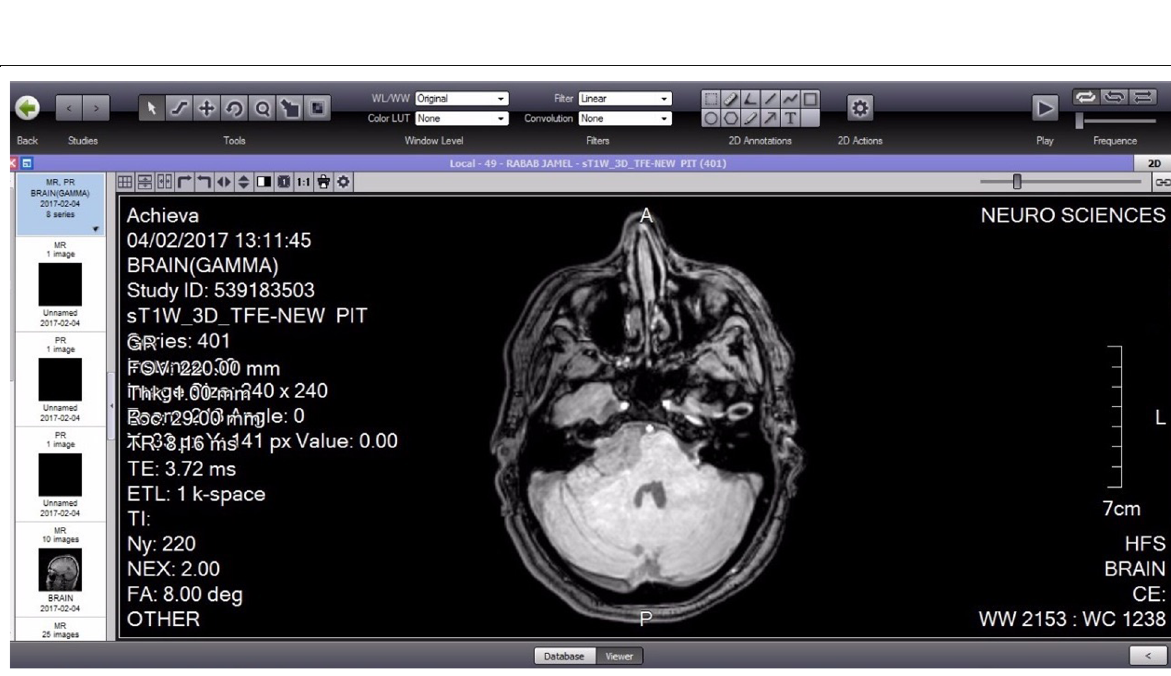
Fig. 2 Onis viewer software used to measure tumor